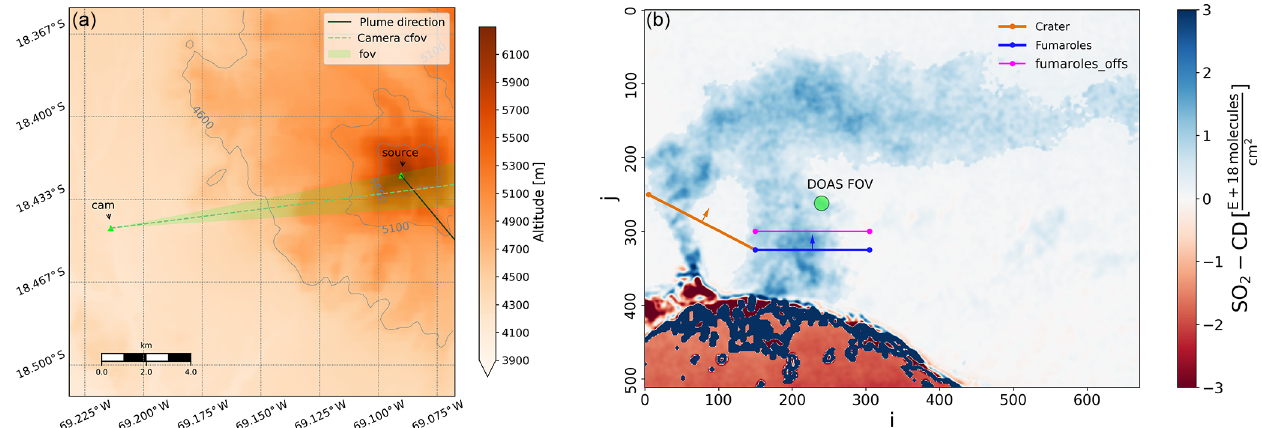
Figure 2. (a) Guallatiri overview map showing position and viewing direction of camera (camera cfov, fov), summit area (source) as well as the plume azimuth (plume direction). (b) Example SO 2 -CD image of the Guallatiri emissions including two PCS lines used to retrieve SO 2 emission rates from the central crater (orange) and from a fumarolic field (blue) located behind the flank in the viewing direction. An additional line (magenta) is used to estimate gas velocities using a cross-correlation algorithm (relative to blue PCS line; cf. Appendix B4). The position and extent of the DOAS-FOV are indicated by a green spot. Note that the displayed plume image is size reduced by a factor of 2 (Gauss pyramid level